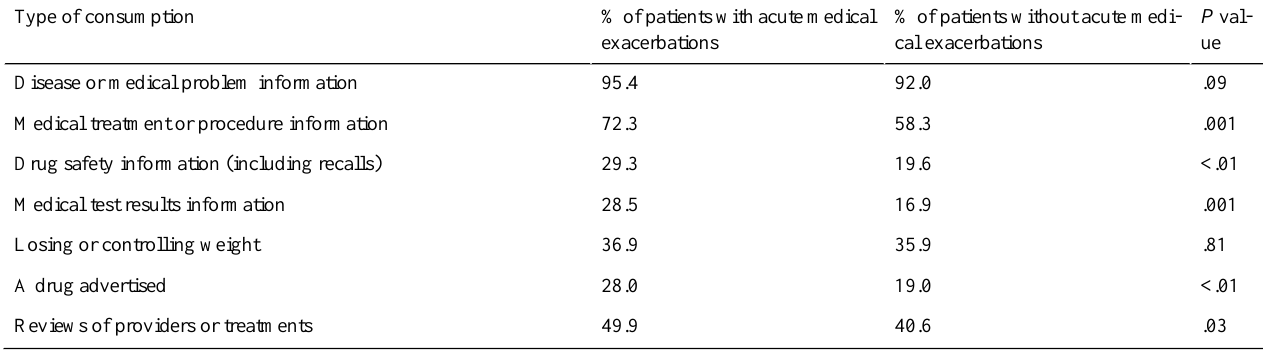
Table 4. Type of consumption among persons with acute medical exacerbations (after multivariate adjustment).